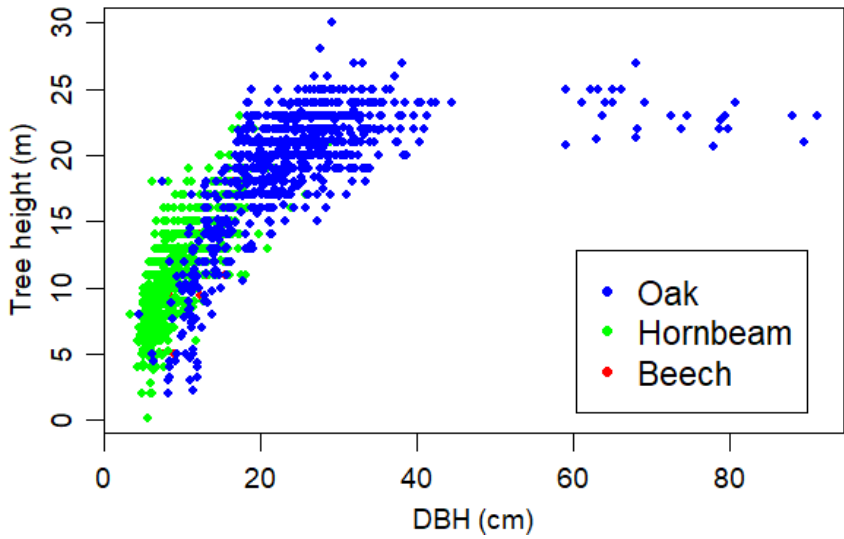
Figure A6. Diameter at breast height (DBH) versus tree height of all measured trees in the three stands with colour ‐ coded species. We show all observations from 2009, 2014, and 2019.